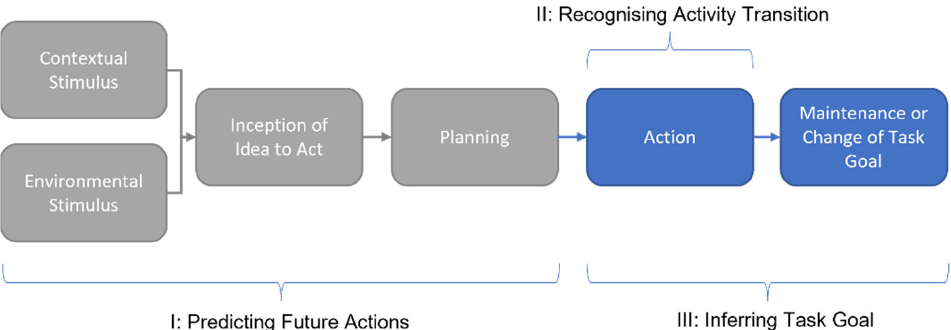
Figure 1. Framework representing the three aspects of intent sensing. Adapted from [1]. Grey regions indicate stages not utilised in this study. Environmental Stimulus indicates change in the user’s surroundings (such as sound or the arrival of another person) that may trigger a response. Contextual Stimulus includes wider factors such as the time of day, typical routine, previous actions etc. The Inception of the Idea to Act represents the user’s conscious decision to take action and predominantly concerns the brain and nervous system. The Planning phase includes any preparation that may take place before the activity begins (such as a visual inspection of the path ahead when about to start walking or the pre-tensing of muscles before attempting a timed grasp). The Action phase covers the real-time execution of the activity, including any changes observable while the activity is being performed. The Maintenance or Change of Task Goal phase looks ahead to the objective of the activity, considering why it is being performed and whether this objective alters over the course of the activity.